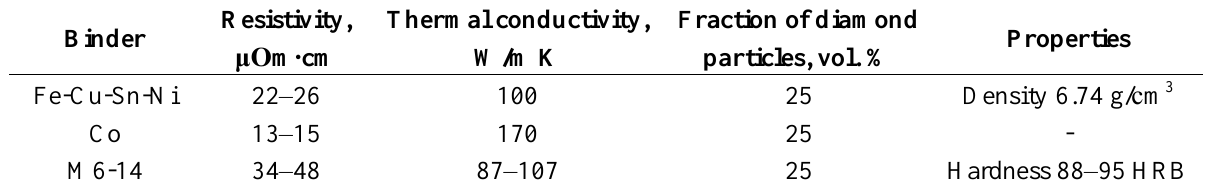
Table 11. Properties of the sintered materials with different